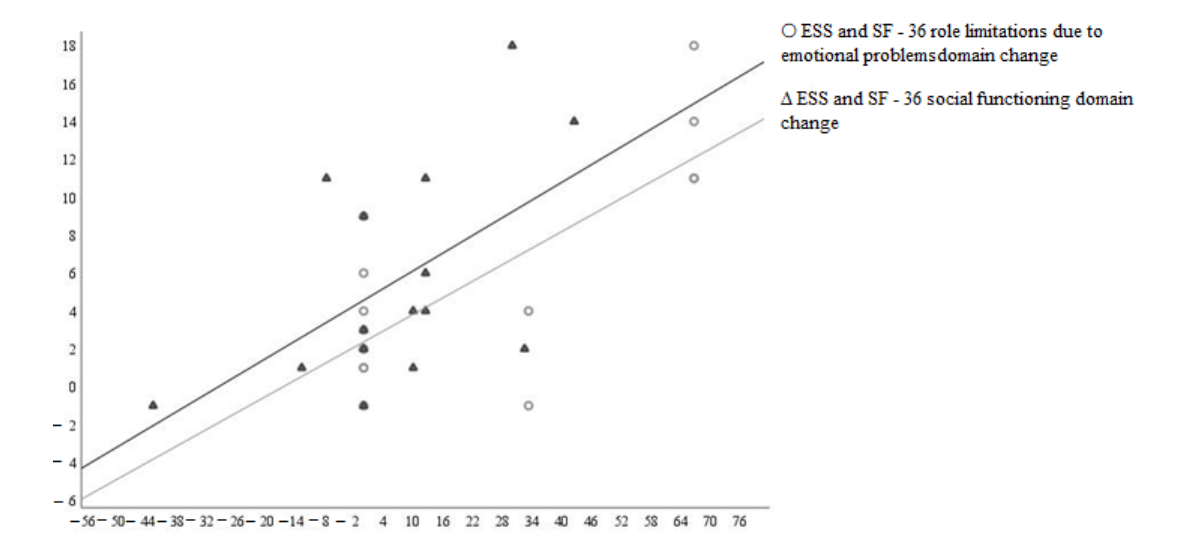
Figure 1. Scatter plot showing the relationship between changes in SF-36 role limitations due to emotional problems and social functioning domains and the Epworth Sleepiness Scale (ESS).